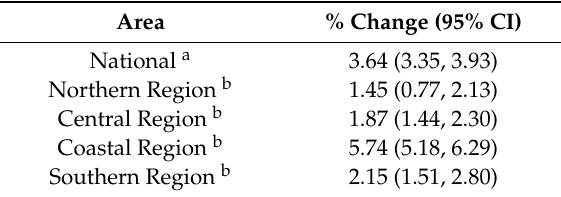
a Model adjusted for time, precipitation and region; b Model adjusted for time, precipitation and